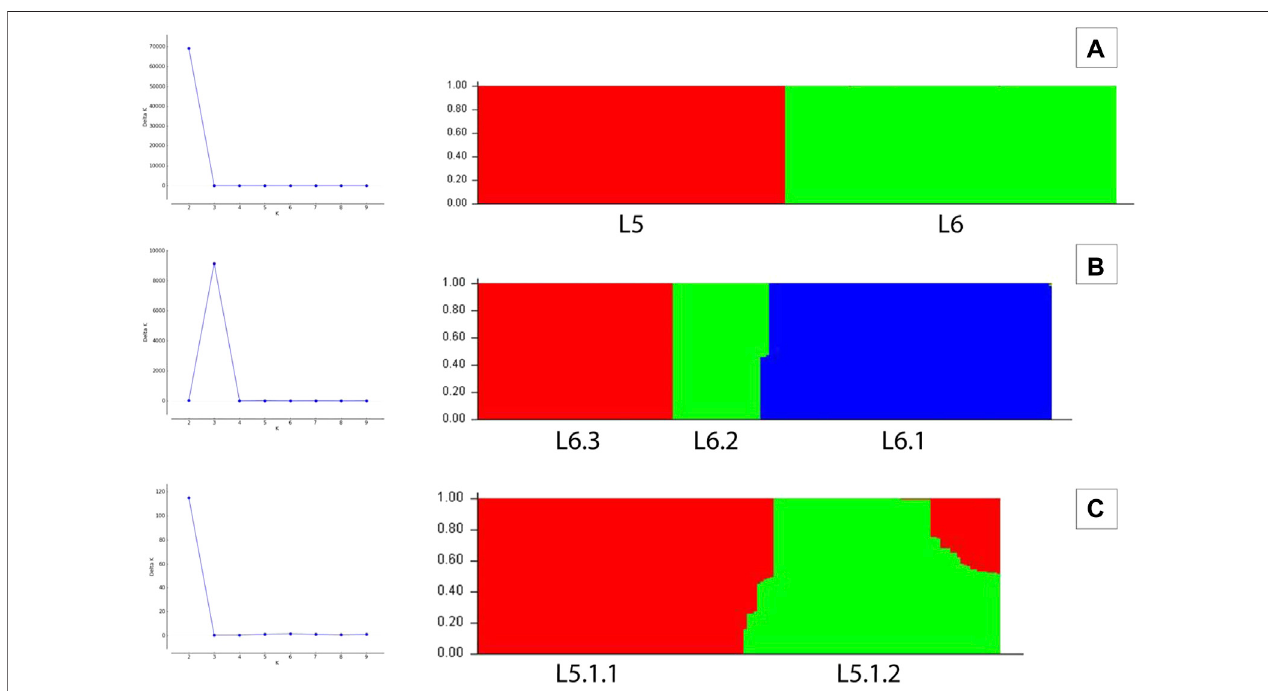
FIGURE5|(A – C) Populationstrati fi cationof Mycobacteriumafricanum basedongenome-wide SNPs[ (A) populationstructure of380samplesoflineagesL5and L6 at k = 2; (B) population structure of 197 samples of lineage L6 at k = 3; (C) population structure of 157 samples of sub-lineage L5.1 at k =